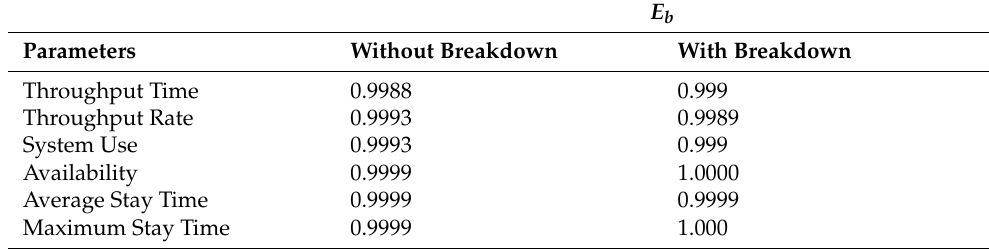
Table 9. Entropy values.